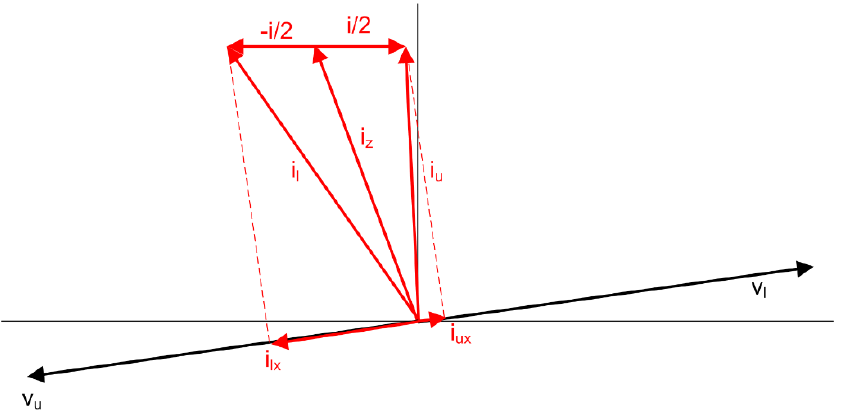
Figure 14. Vector diagram of the variables involved in the transmission of power from the arms when the generation has a large imbalance between arms. All of them are 50 Hz variables (harmonic 1).